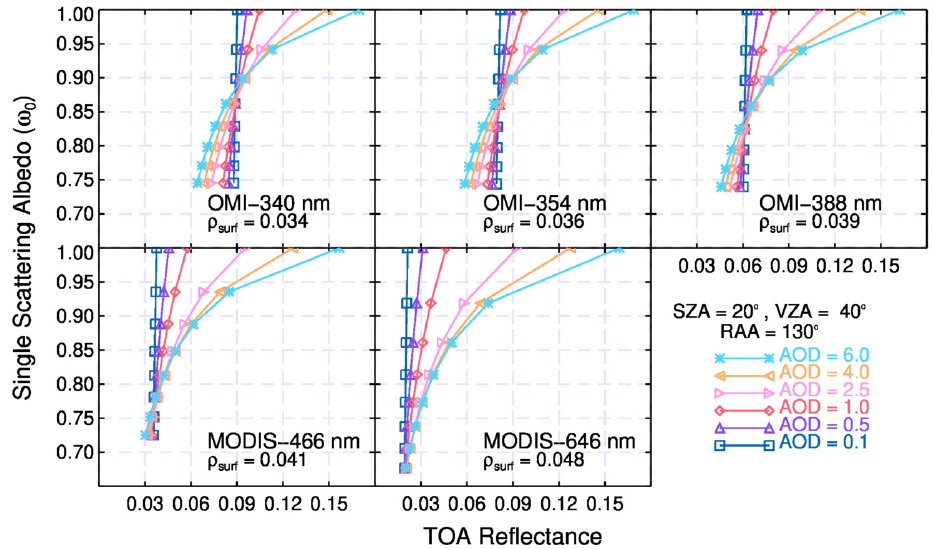
Figure 3. Simulated TOA radiances for the aerosols over the GSFC site as a function of τ and SSA in the UV–visible